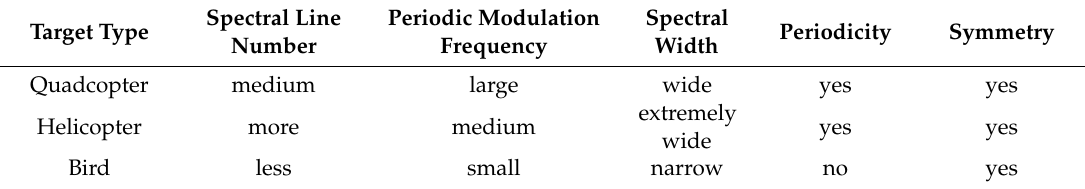
Table 2. DMS feature comparison of three typical low altitude, small radar cross-section (RCS), and slow speed (LSS)